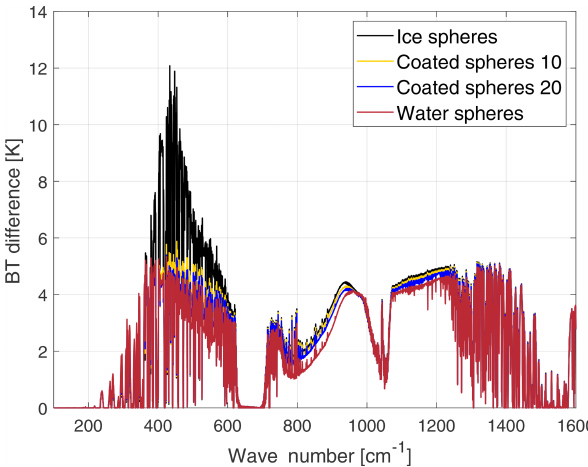
Figure 4. Brightness temperature sensitivity to the particle phase. A polar cloud is assumed made of a particle size distribution of spheres of ice (black line), liquid water (red) and two mixed phases. The mixed phase are spheres with an ice core and liquid water coat- ing. The coating is, respectively, 10% (yellow line) and 20% (blue line) of the total sphere radius. Cloud optical depth is 7, cloud thick- ness is 1.5km and cloud altitude is 5km. The BT differences are obtained in reference to an Antarctic clear-sky case over a snowed surface.